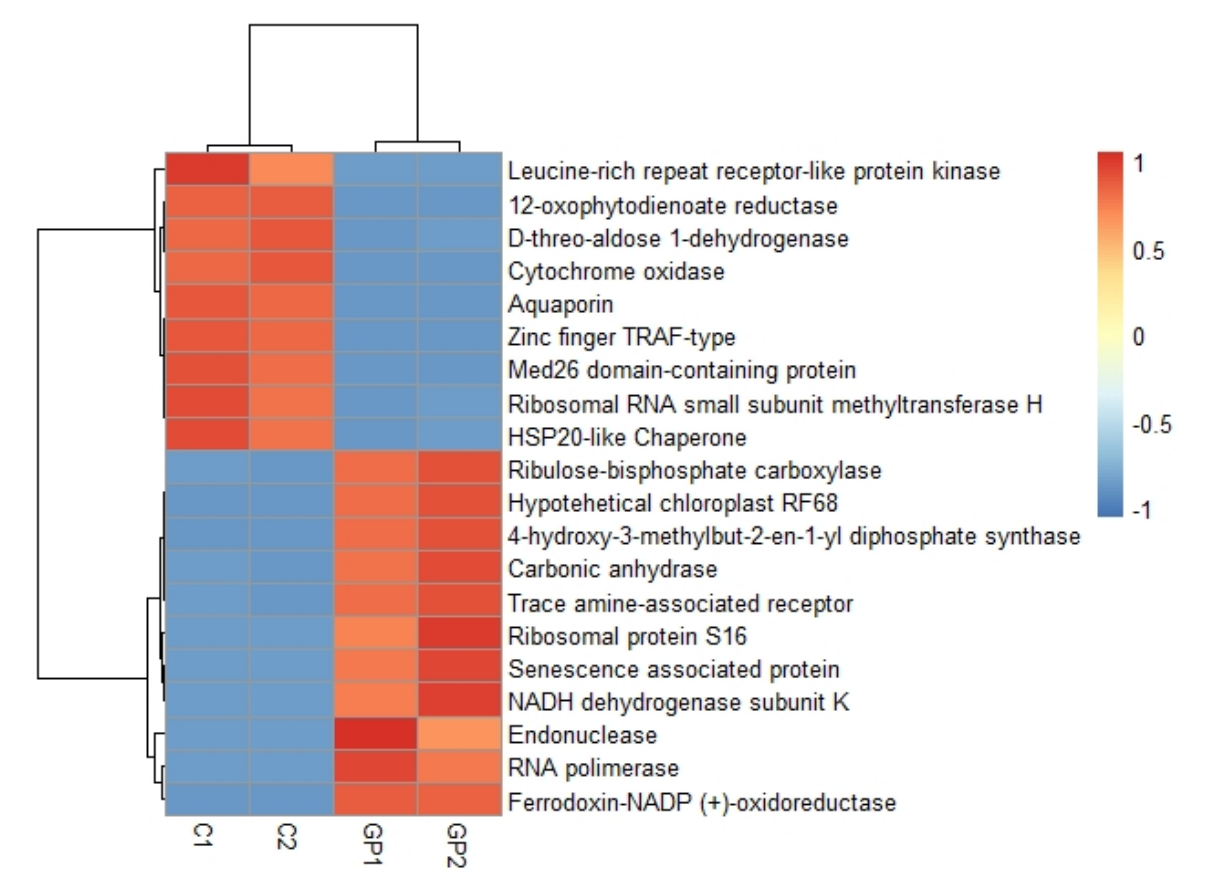
Figure 5. Comparison of transcripts with higher differential expression values between leaves and roots of galphimine producer plants. C1, C2 (roots). GP1, GP2 (leaves). High values are represented in red color, the lowest values are represented in blue.